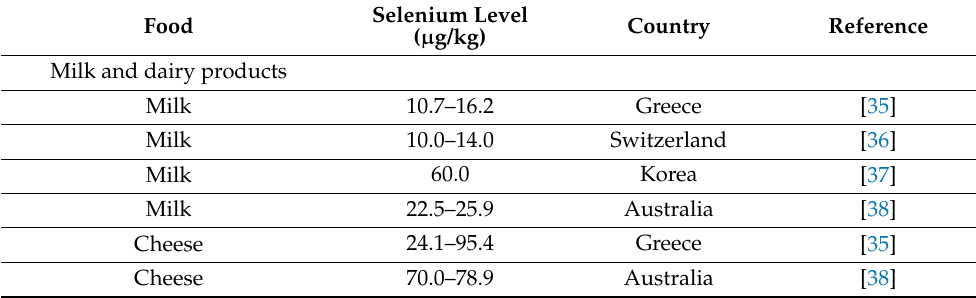
Table 1. Typical Selenium levels in food from selected